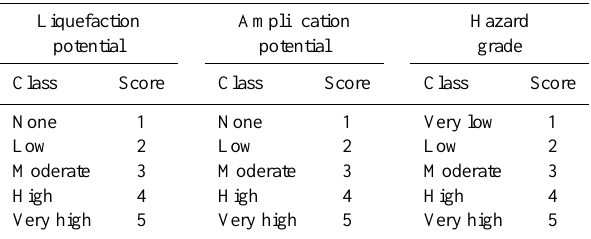
Table 4. Classifications and simple weighting points used in the